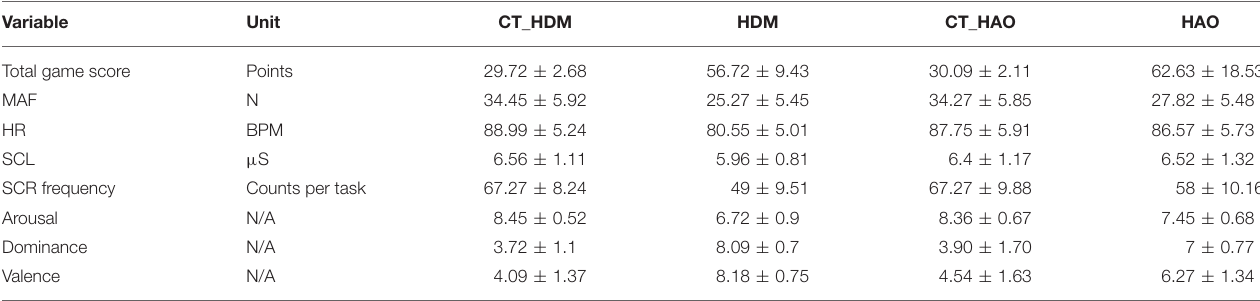
TABLE 4 | Mean values with SD for the eight measured variables during the 5-min calibration and 5-min closed-loop tasks for the HDM and HAO controller.